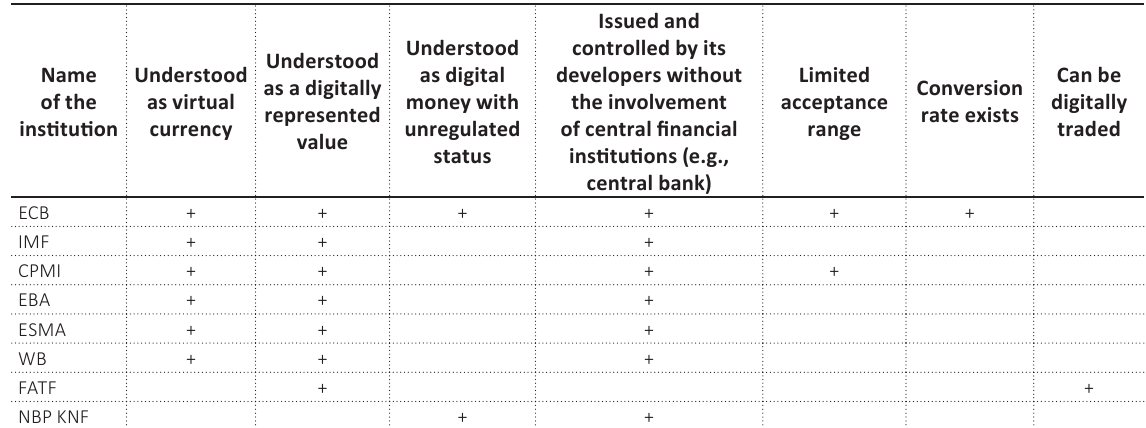
Table 2. Cryptocurrencies in the light of the selected central financial